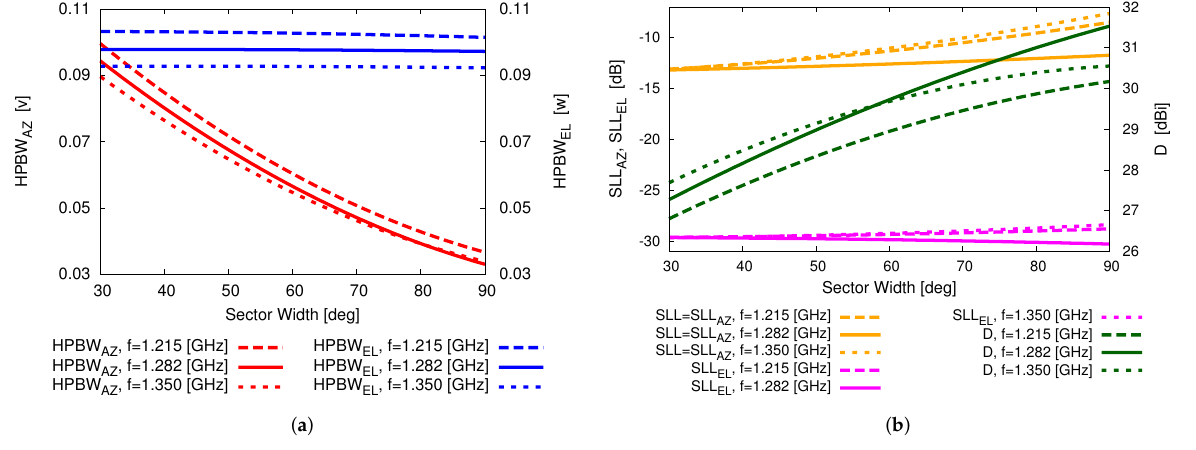
Figure 12. Numerical Assessment (Sparse CPA, M = 16, d = λ ( a ) HPBW AZ and HPBW EL and of ( b ) SLL and D versus the vertical sector width, ψ